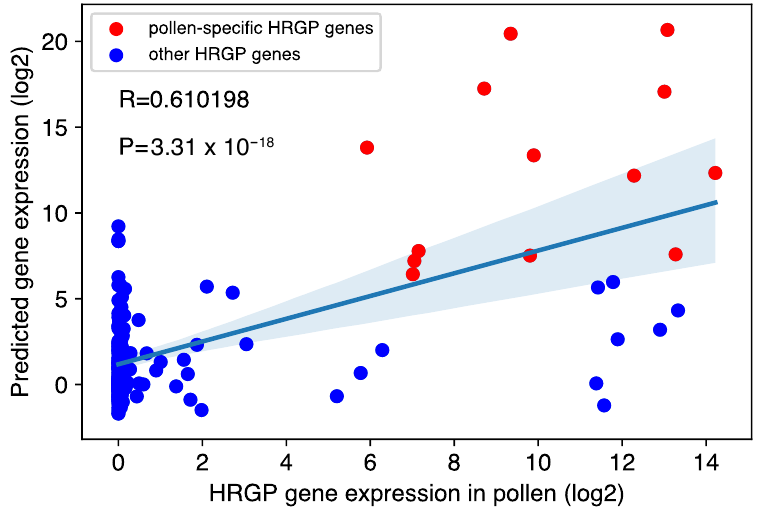
Figure 3. Regression analysis using the identified 15 pollen-specific motifs. Each point is an HRGP gene. Pollen-specific HRGP genes are highlighted in red. The X-axis is the mean HRGP gene expression in pollen and the Y axis is the predicted gene expression value. The Pearson correlation coe ffi cient is 0.61 and the p -value is 3.31 × 10 − 18